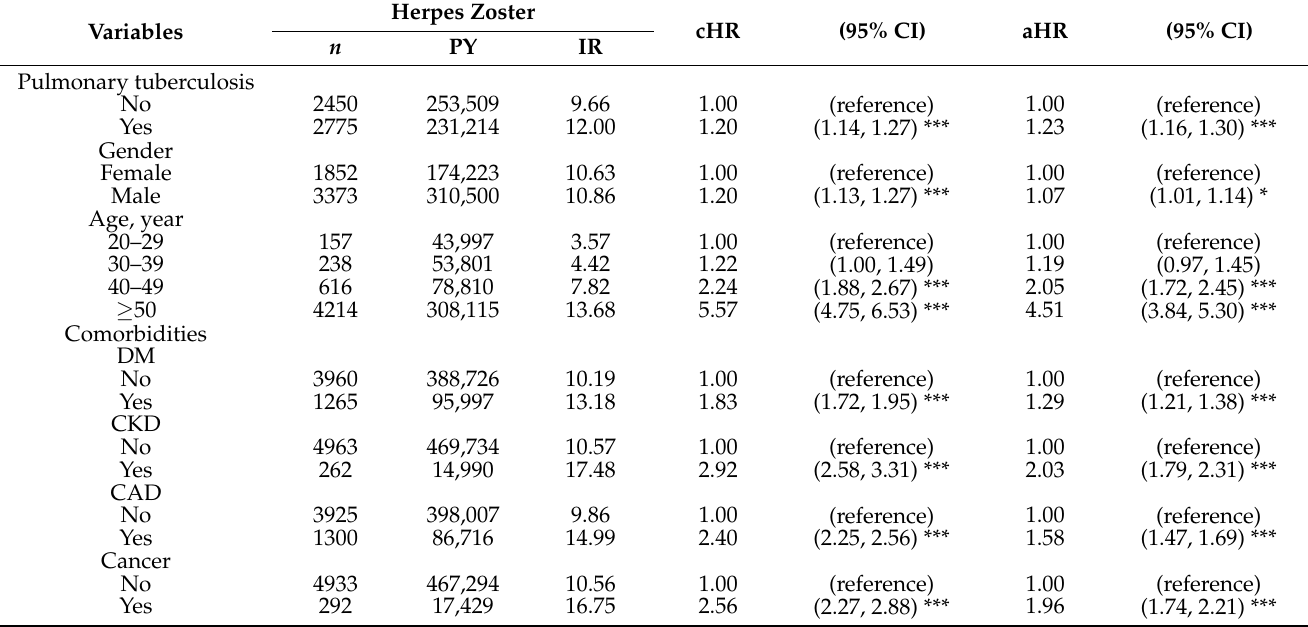
Table 2. Incidences and hazard ratios of herpes zoster for individuals with and without pulmonary tuberculosis by gender, age, and comorbidities.